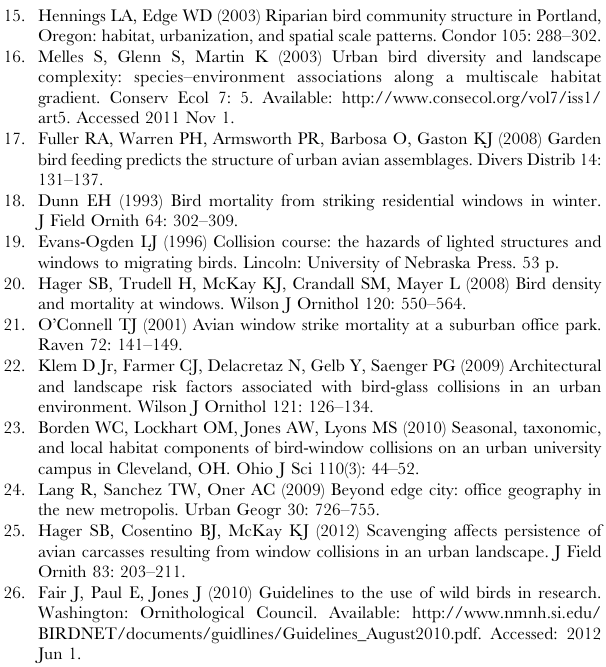
Table S2 Seasonal sampling structure that correspond- ed to migration strategy and timing of breeding in Illinois, USA, 2010. Table S3 List of study buildings, land cover categories, window area, development, presence of feeder stations, and number of carcasses documented and predicted in Illinois, USA, 2010. Table S4 Maximum number of individuals observed for each species during point count surveys and total carcasses (shaded and in parentheses) resulting from window collisions at each study building and season in Illinois, USA, 2010. (PDF) Text S1 Analysis of detection